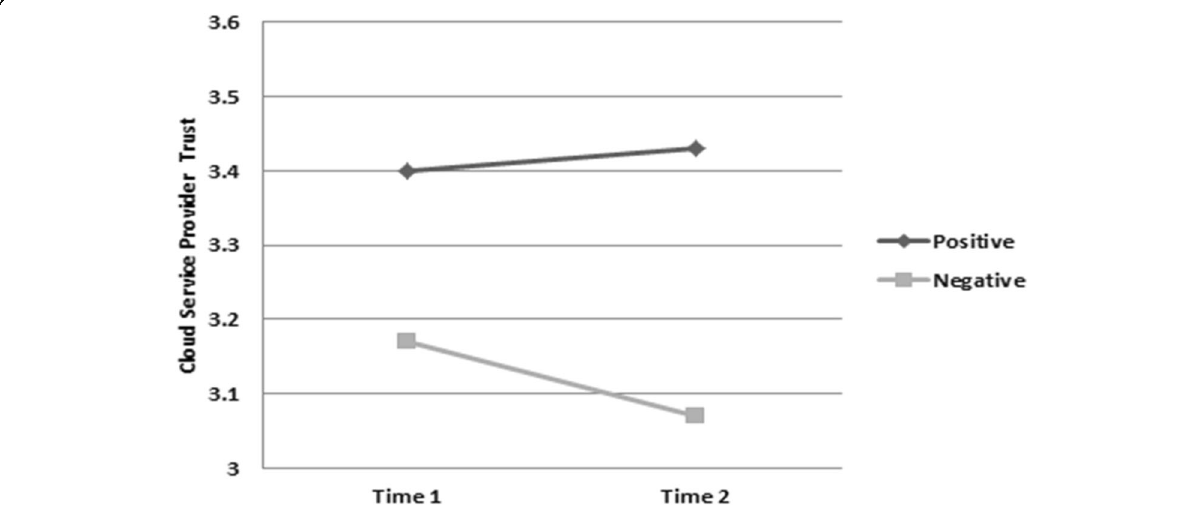
Fig. 10 CSP Trust means by condition at Time 1 and Time 2. The figure shows the difference in trust in the CSP between time 1 prior to exposure to the label and time 2 after exposure to the label. As shown, exposure to the positive label led to a slight increase in CSP